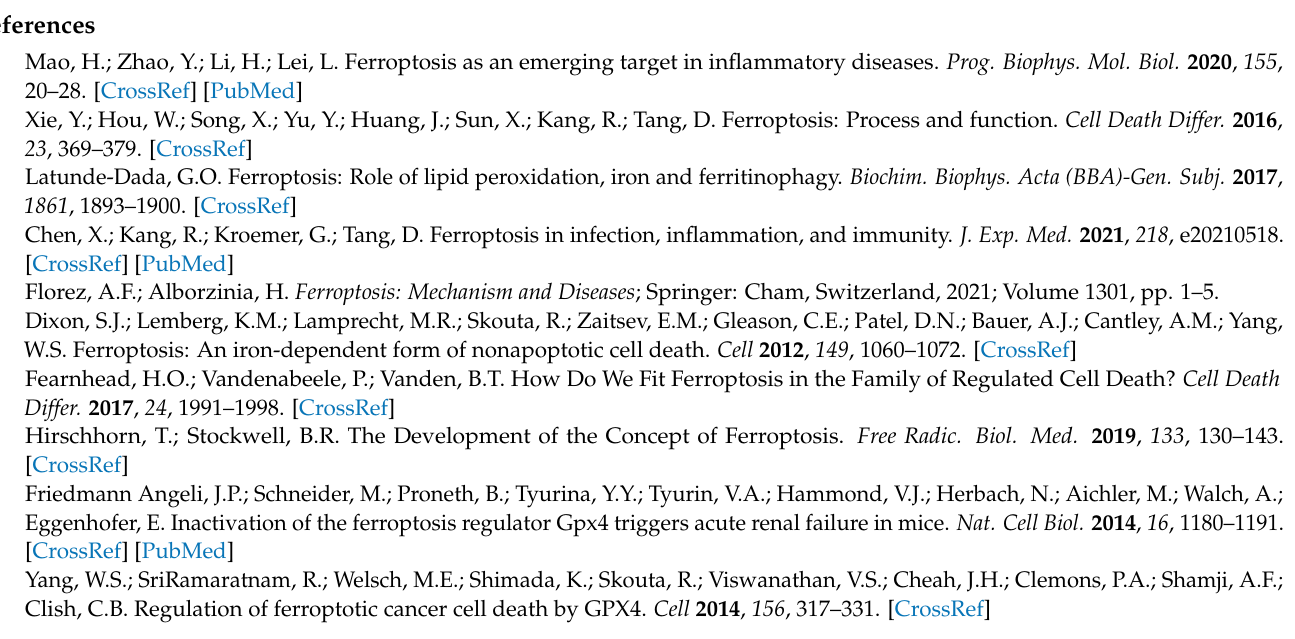
Table S3: qRT-PCR primer sequences; Table S4: The 819 significantly biological processes identified the from the DIA proteomics; Table S5: The 302 candidate DEPs associated with ion homeostasis and cell development; Table S6: The pathways in which HMOX1 is involved and candidate DEPs; Table S7: The DEPs shared between biological processes and the nine pathways; Table S8: The 13 proteins related to ferroptosis in the DIA proteomics